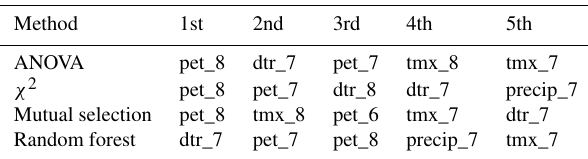
Table C2. Rank of the most important features for different fea- ture selection methods along the entire soybean growing season: ANOVA, mutual information selection, random forest classifier and χ 2 . Variables considered are maximum monthly temperature (tmx), precipitation (precip), diurnal temperature range (dtr), vapour pres- sure (vap), potential evapotranspiration (pet) and cloud cover (cld). Numbers 7 and 8 indicate the months of July and August, respec-